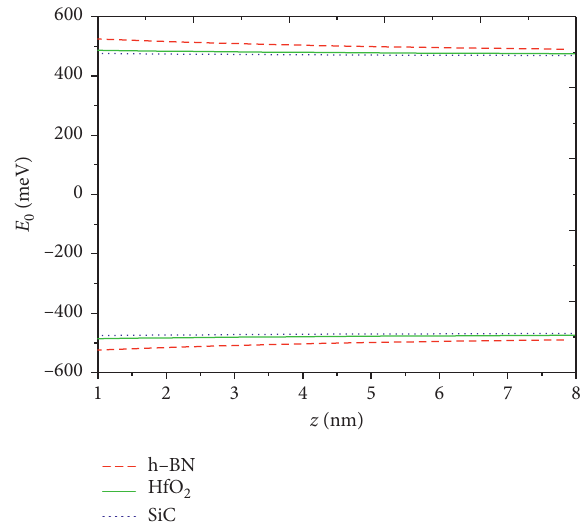
Figure 4: Variable substrate distance z versus the ground energy E 0